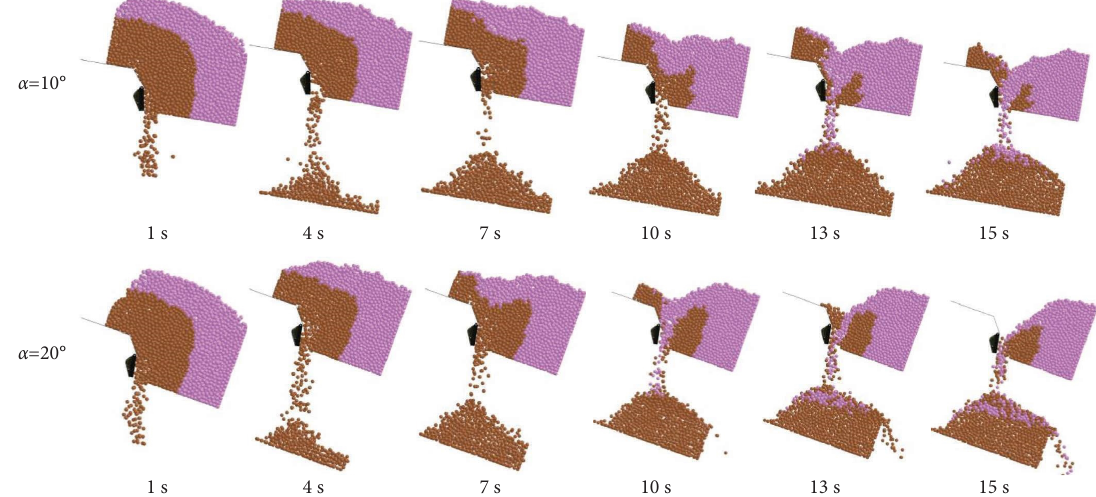
Figure 27: Te coal-caving process when the angle of elevation is 10 ° and 20 °